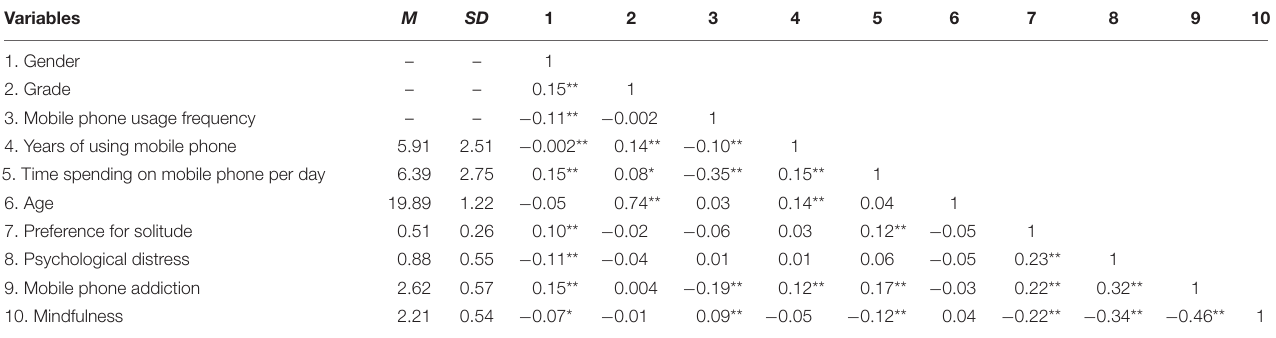
TABLE 1 | Descriptive statistics and interrelations among all of the observed variables.